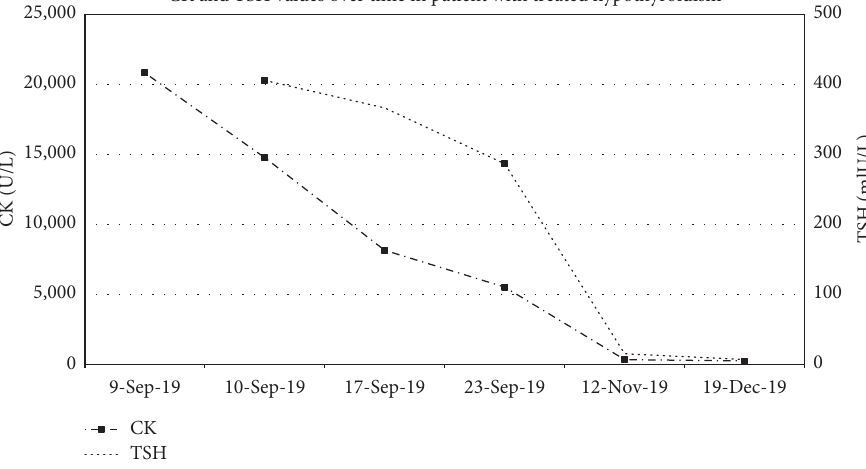
Figure 1: CK and TSH values over time in patient with treated